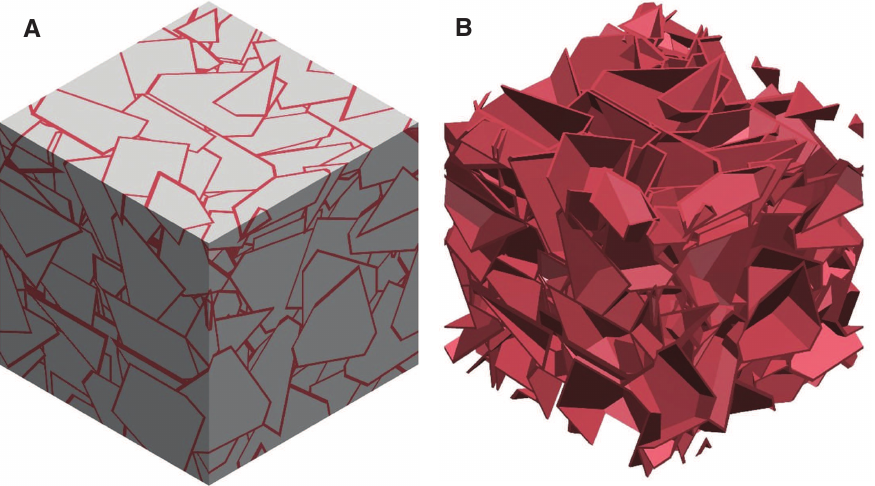
Figure 7: Three-dimensional microgeometry containing 9% Co and continuous boundaries between tungsten carbide particles: (A) isometric view and (B) detailed view on the cobalt phase.